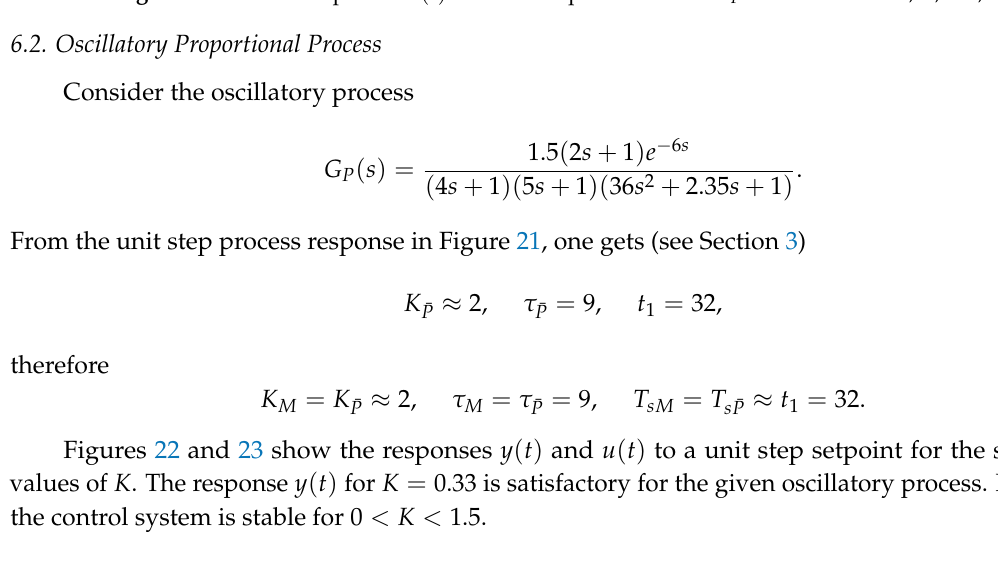
Figure 20. Control responses u ( t ) to a unit step reference for T F = 4 and K = 0.5; 1; 2.4; 5.